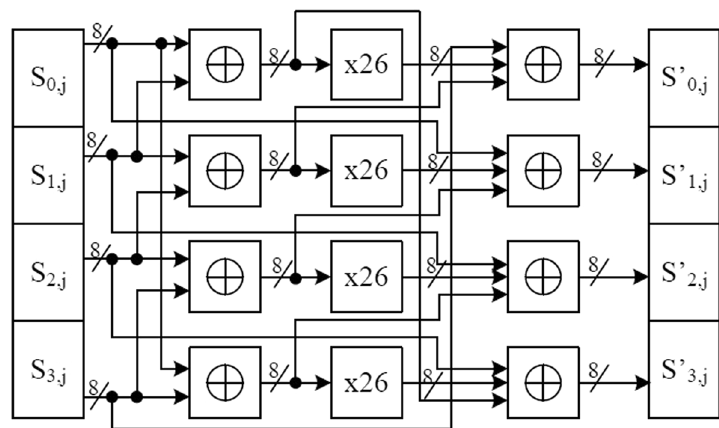
Fig. 10 MixColumns operation in composite field GF((2 4 ) 2